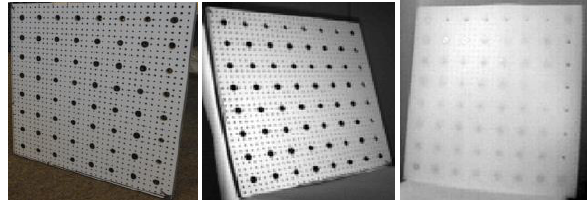
Figure 2. Calibration table with raster on the white surface. From left to right: RGB image of the calibration table, NIR image, TIR image. The big black points are painted screws with a raster size of 6 cm. The points are visible both in the NIR and TIR